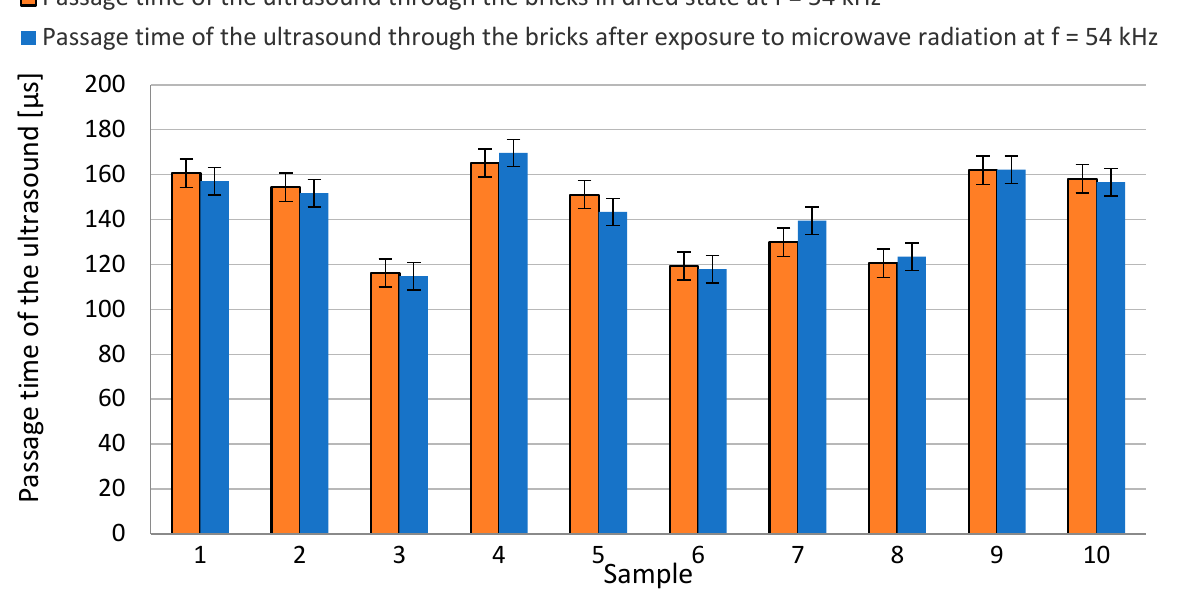
Table 5. Overview of the average passage time of the ultrasonic wave.